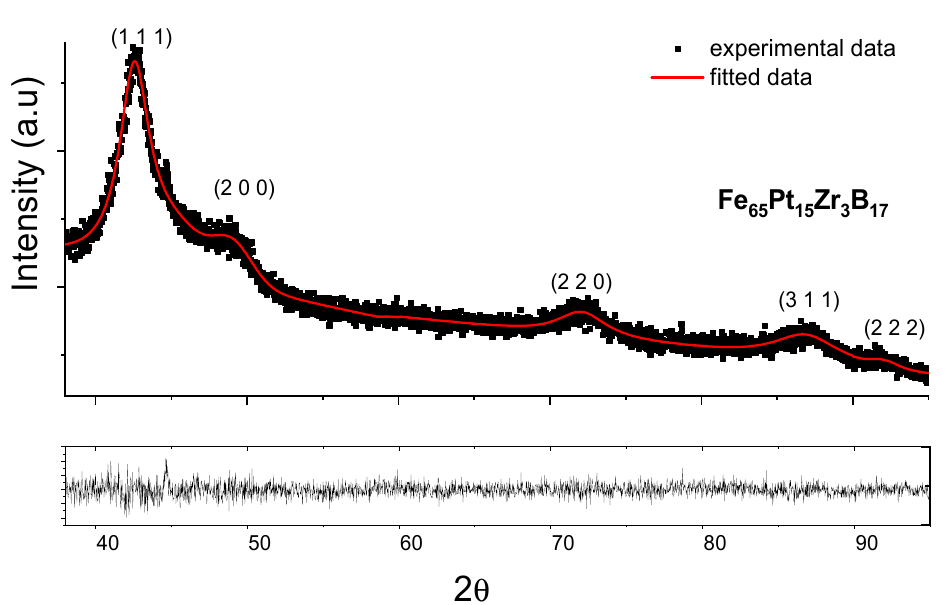
Figure 1. X-ray diffractogram of as-cast Fe 65 Pt 15 Zr 3 B 17 sample fitted with the MAUD software. The indexed lines belong to fcc A1 FePt. Bottom graph is the difference between fitted and experimental data.